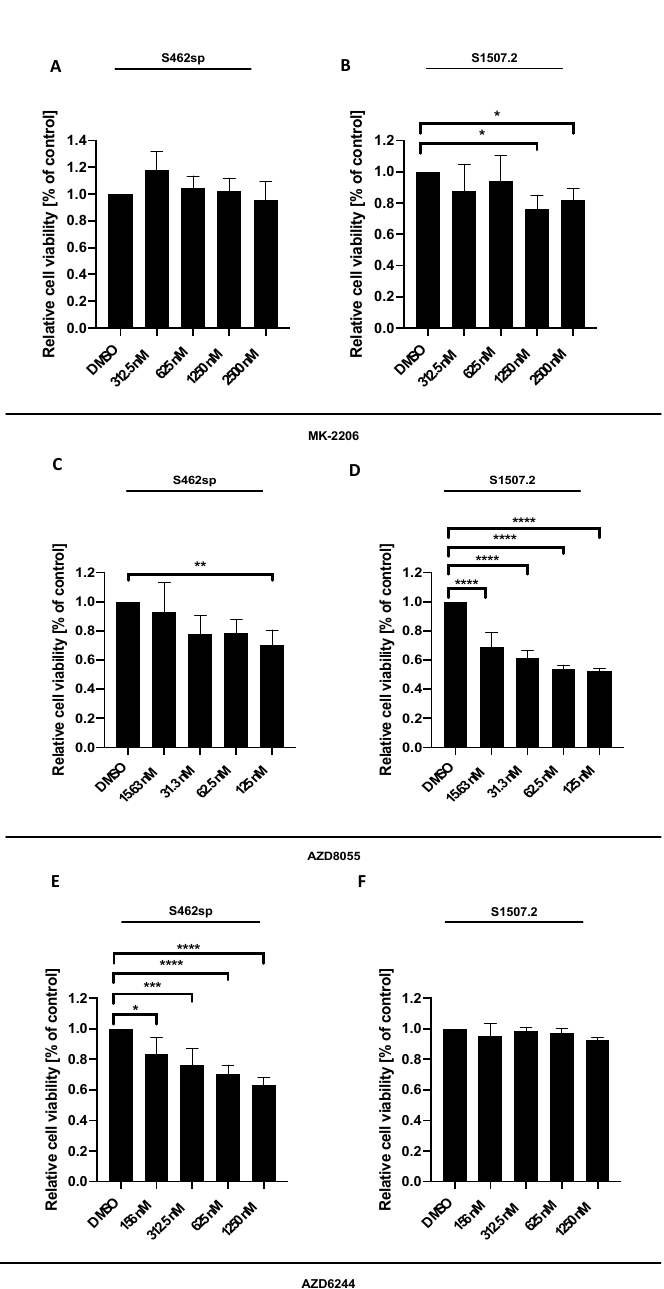
effects on the viability of the two MPNST cell lines analysed, with some differences regarding the concentration-dependent response (Figure 1).